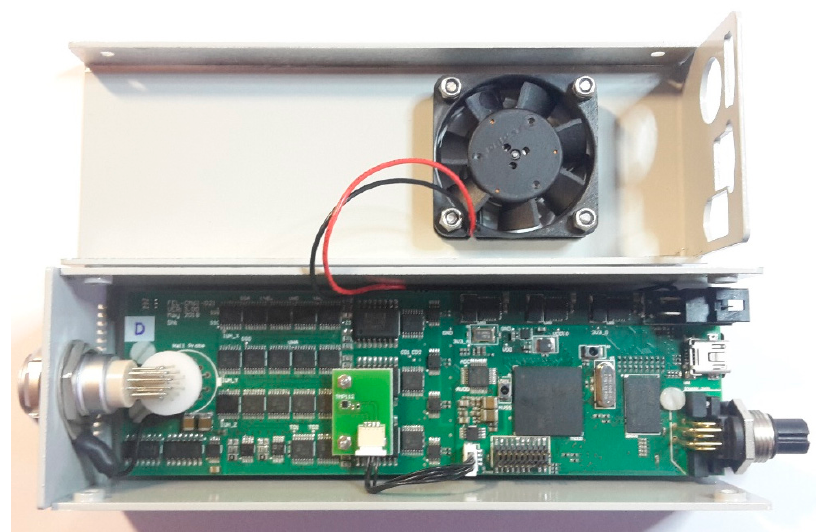
Figure 3. Photo of the complete instrumentation board inside the aluminum enclosure. The Hall probe connector is located on the narrow left-hand side of the board with all digital and supply connectors on the opposite side.